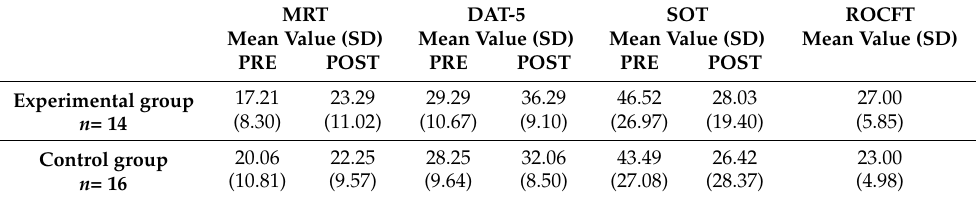
Table 2. Statistical description of data.